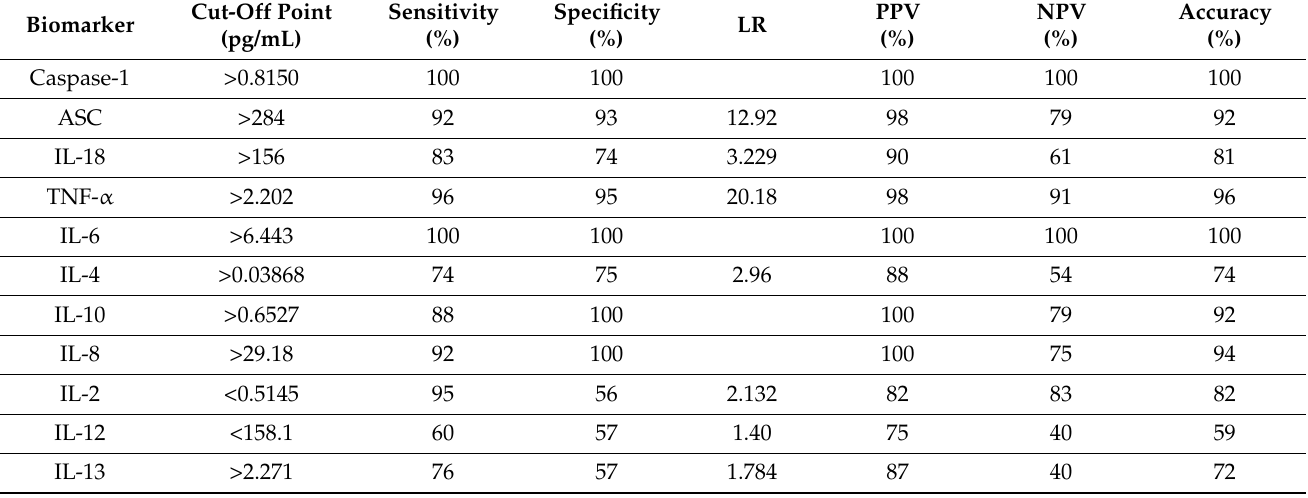
Table 1. ROC Analysis. Table 2. Cut-off point in serum of TBI